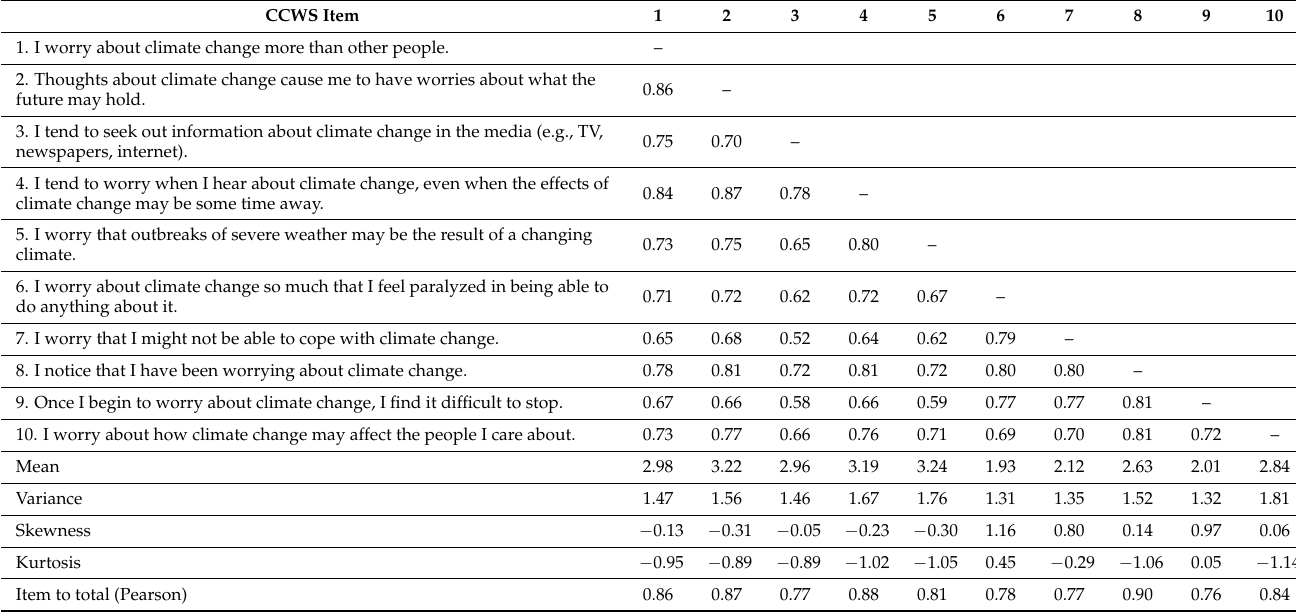
Table 2. Polychoric correlations of the Climate Change Worry Scale items ( n =